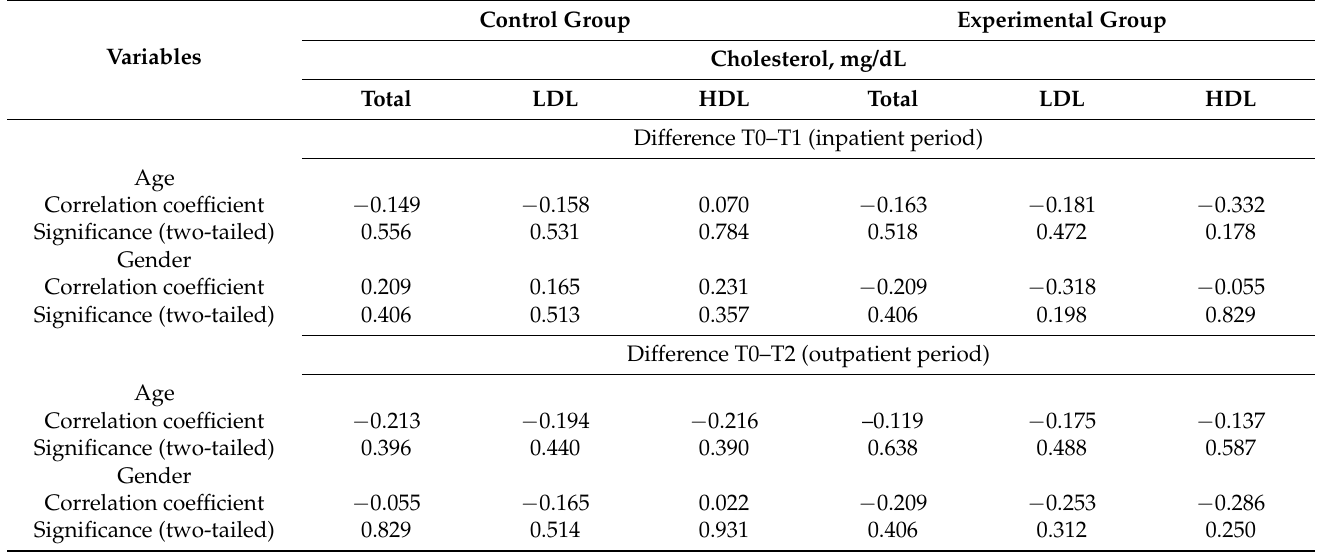
Table 8. Correlation between patients’ age, gender and cholesterol profiles during the